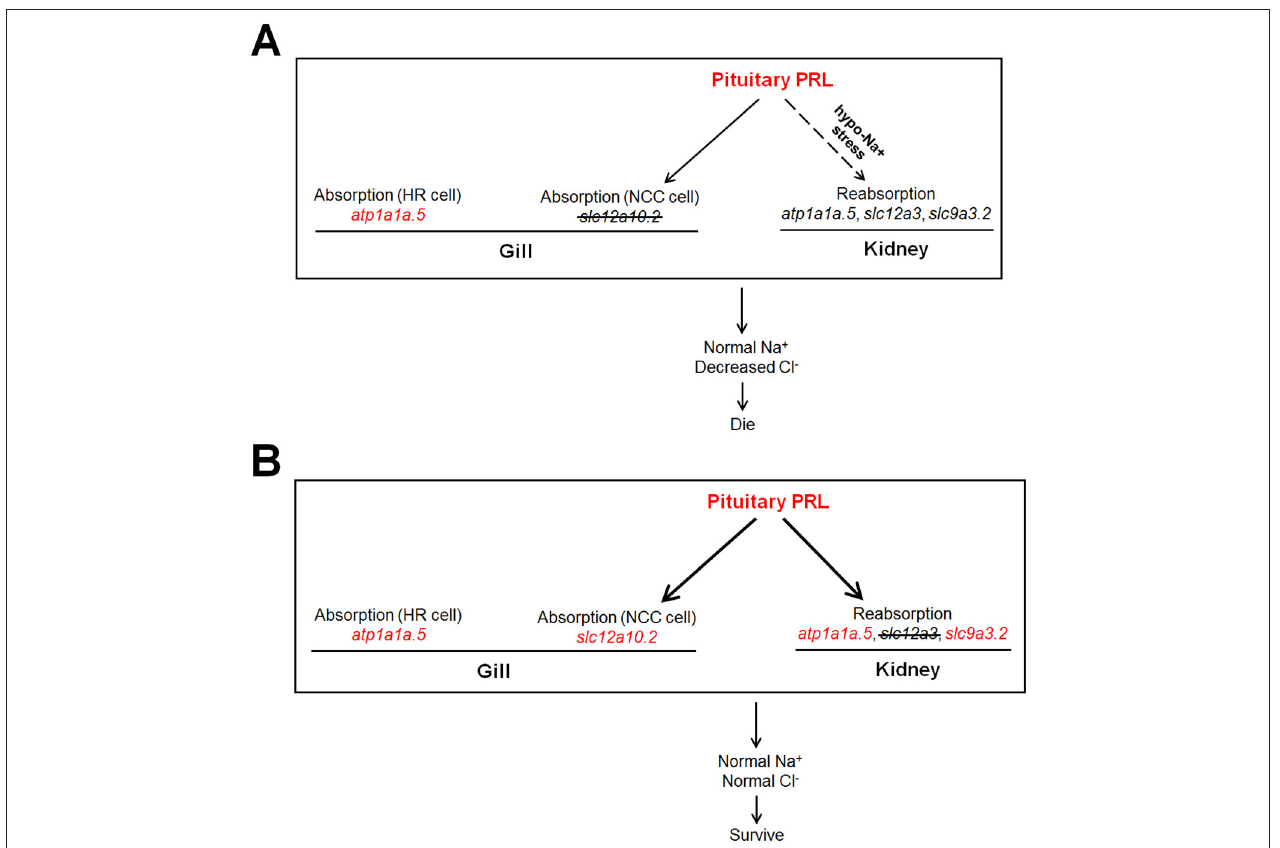
FIGURE 7 | The dissected regulatory network of PRL signaling in the slc12a10.2 - and slc12a3 -deficient fish, respectively. (A,B) The generations of the model with increased endogenous PRL in zebrafish. Either depletion of slc12a10.2 or slc12a3 could result in increased endogenous PRL effectively. (A) Although pituitary prl is upregulated in the slc12a10.2 -deficient fish, the responses of PRL downstream targets in pronephric duct to upregulated prl is not observed, as this pathway could only be conditionally activated under the hypo-Na + stress. The Na + absorption maintenance by upregulated atp1a1a.5 in the gills/skin of the slc12a10.2 -deficient larvae is evidently observed, which probably compensate to maintain the systemic Na + concentration. However, the PRL downstream targets in the pronephric duct failed to respond to the increased pituitary PRL. (B) The overall responses of Na + and Cl − absorption both in the gills/skin and reabsorption in the pronephric duct compensate to maintain normal levels of Na + and Cl − in the slc12a3 -deficient fish. The upregulated expressions of the nominated genes are highlighted in